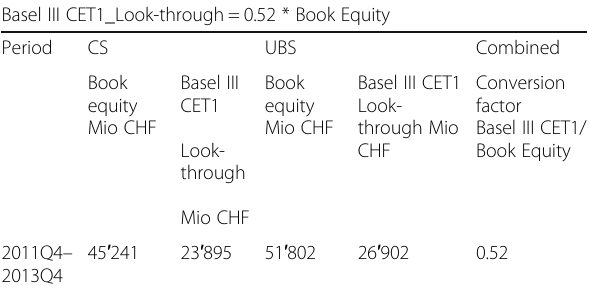
Table 9 Conversion factor: Basel III CET1 Look-through to Book Equity